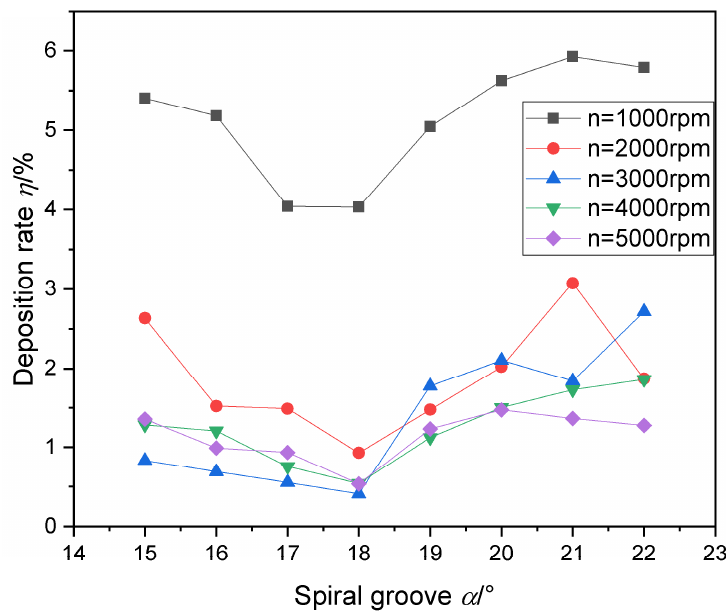
Figure 11. Influence of spiral angle on the deposition rate.